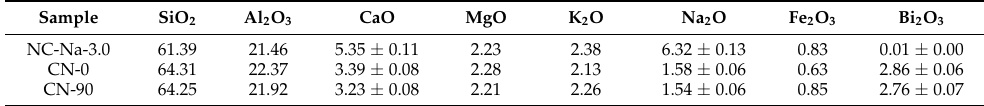
Table 1. X-ray fluorescence spectroscopy (XRF) results of clinoptilolite supports before and after ion exchange with bismuth nitrate at different temperatures